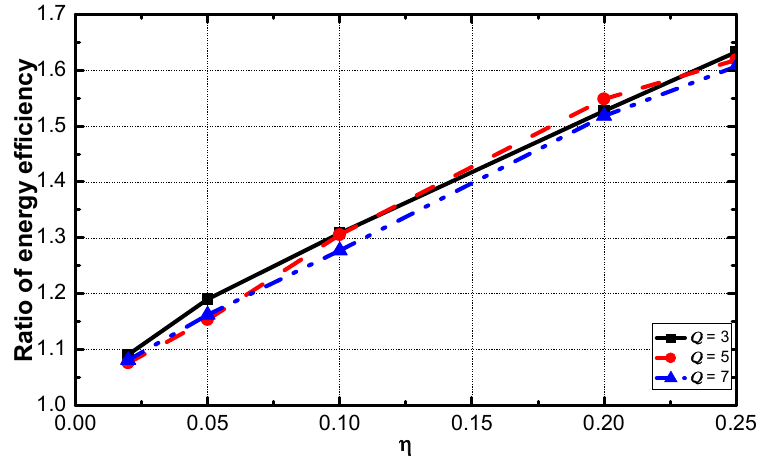
Figure 18. The ratio of energy efficiency vs. η .